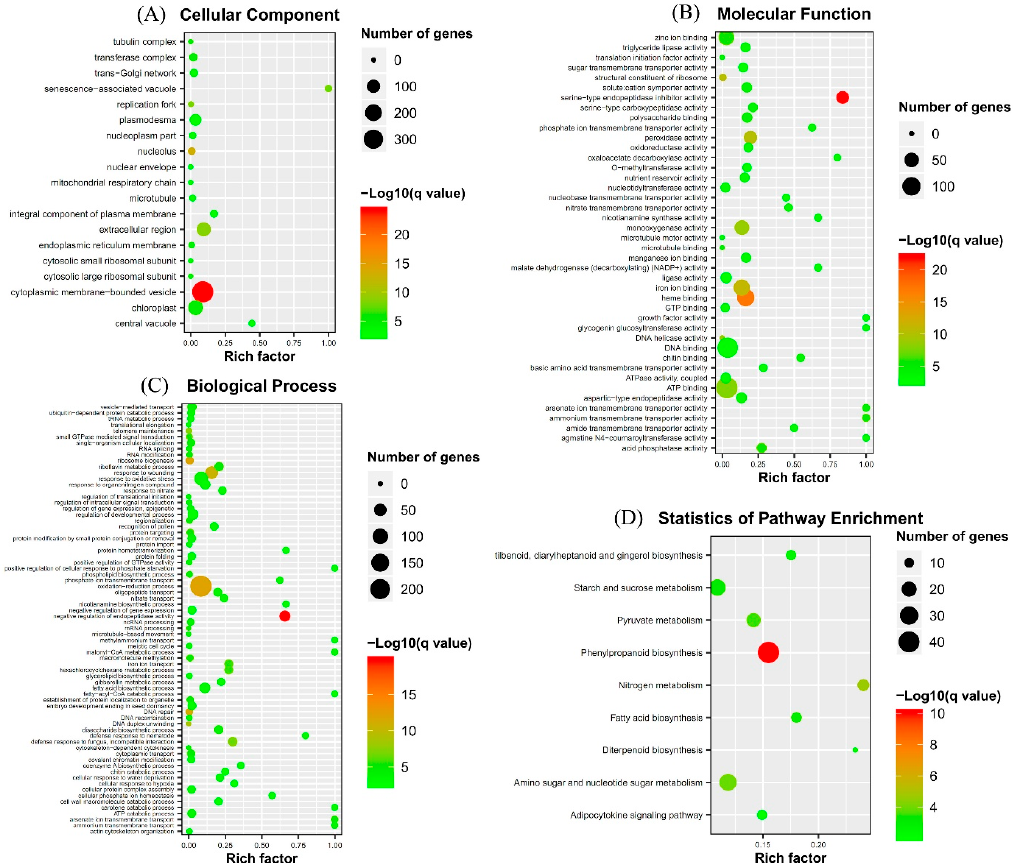
Figure 3. Gene Ontology (GO) term and Kyoto Encyclopedia of Genes and Genomes (KEGG) pathway enrichments of DEGs in response to AM fungus. ( A ) Cellular component, ( B ) Molecular function, ( C ) Biological process, and ( D ) KEGG pathway. Rich factor, percentage of genes in the background pathways.